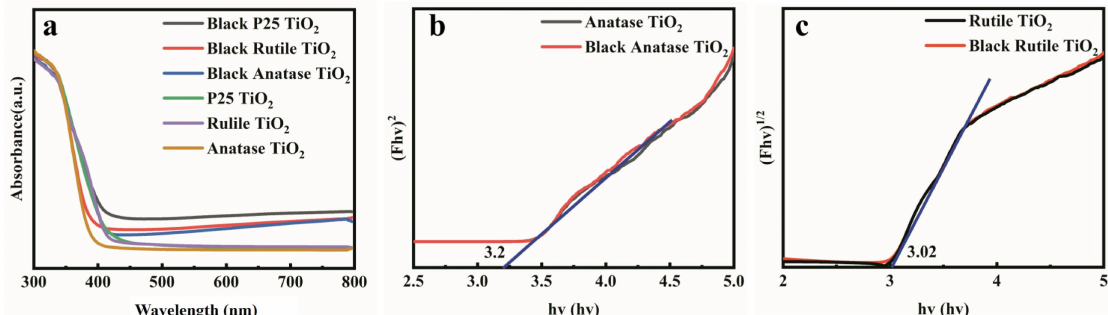
Figure 5. ( a ) The UV–vis absorption spectra of six samples of P25 TiO 2 , rutile TiO 2 , anatase TiO 2 , black P25 TiO 2 , black rutile TiO 2 , and black anatase TiO 2 ; ( b ) Plots of (Ah ν ) 2 vs. photon energy of anatase TiO 2 and black anatase TiO 2 ; ( c ) Plots of (Ah ν ) 2 vs. photon energy of rutile TiO 2 and black rutile TiO 2 . The blue lines are the fits to be tangent to the experimental